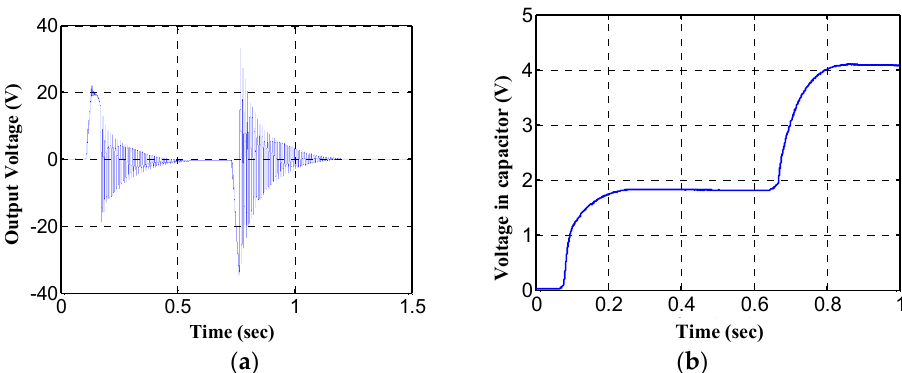
Figure 13. Measurement result of electric generation from the designed piezoelectric harvesting floor, which includes; ( a ) Voltage output from piezoelectric unimorph plate; ( b ) Voltage charging situation in storage capacitor.